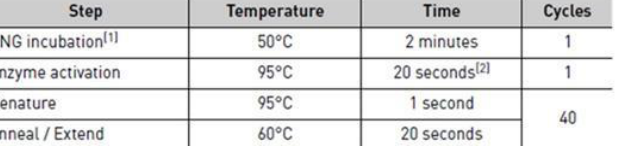
Figure 1. The TaqMan Array working protocol applied to hemangioma samples for VEGF pathway gene expression profile assessement.